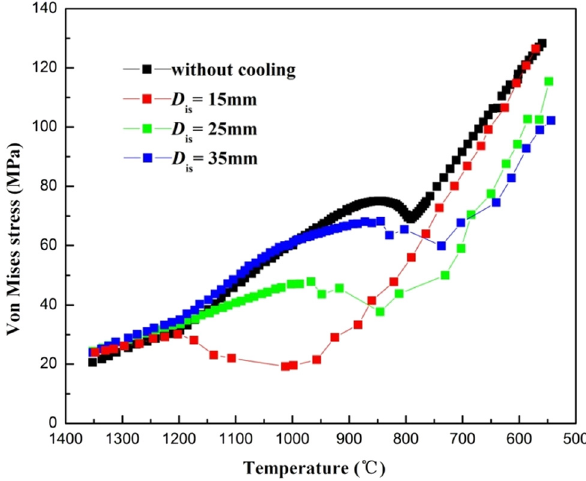
Figure 12: E ff ect of distance between cooling source and heat source on the transient von Mises